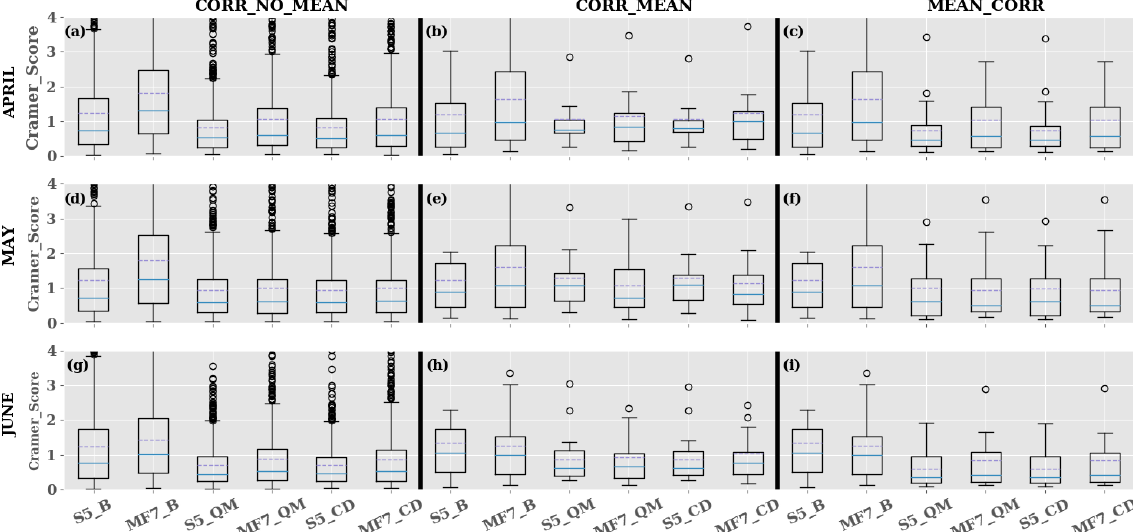
Figure 9. Bias correction evaluation using Cramér–von Mises score over the JJAS period during 1993–2016 on the central SHL box at different forecast initialization months: (a–c) April, (d–f) May and (g–i) June. The CORR_NO_MEAN, CORR_MEAN and MEAN_CORR methods are well described in Sect. 3.4. S5_B, S5_CD and S5_QM represent the Cramér score computed using the SEAS5 raw forecasts, SEAS5 corrected with CDF-t and QMAP methods respectively. The same applies to MF7_B, MF7_CD and MF7_QM with the MF7 model. The y axis indicates the Cramér score and x axis the different products used for the computation of the Cramér